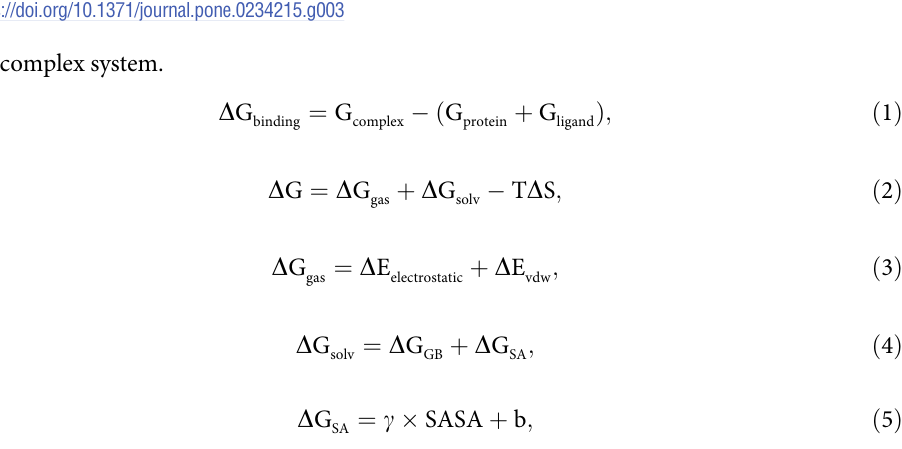
Fig 3. Chemical structures of S . aureus HK/WalK inhibitors. (1) Waldiomycin (IC 50 10.2 μ M) and (2) waldiomycin methyl ester (IC 50 75.8 μ